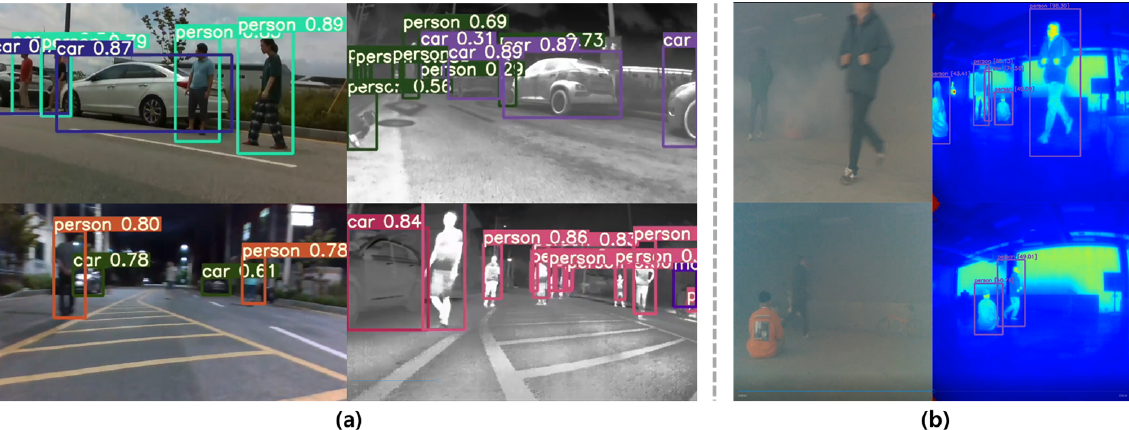
Figure 21. Examples of human and car detection results during ( a ) day- and nighttime and ( b ) fog environment.